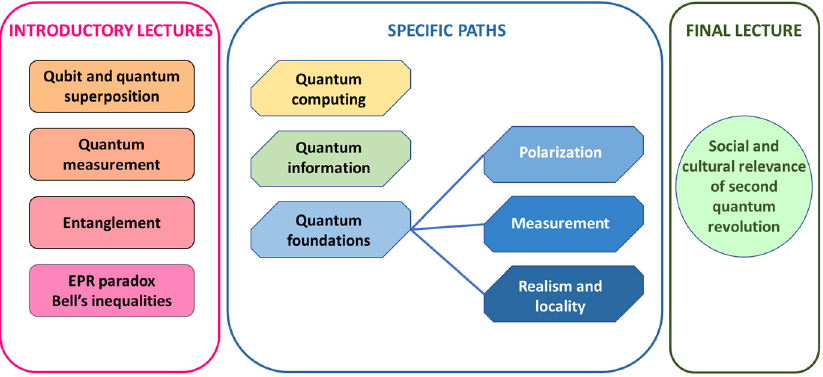
Figure 1. Overview of the educational path activities.